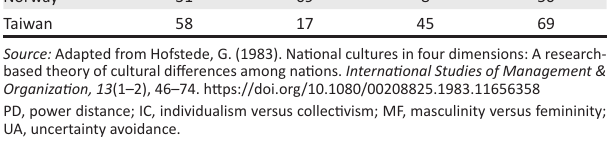
TABLE 1: National dimensions of culture. Country